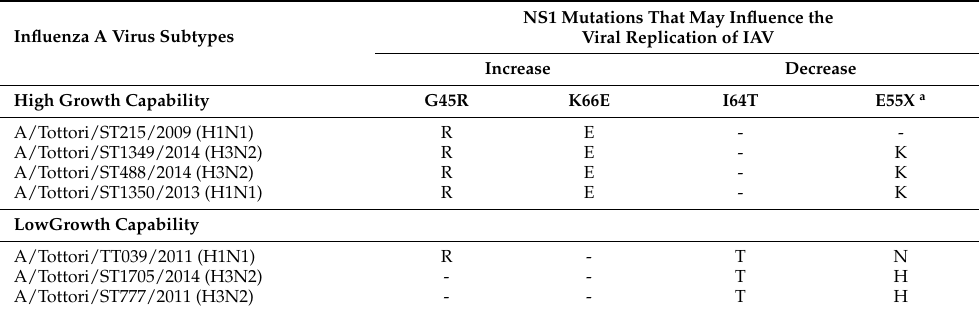
Table 2. NS1 mutations present in seasonal influenza A virus that may influence the viral replica- tion.